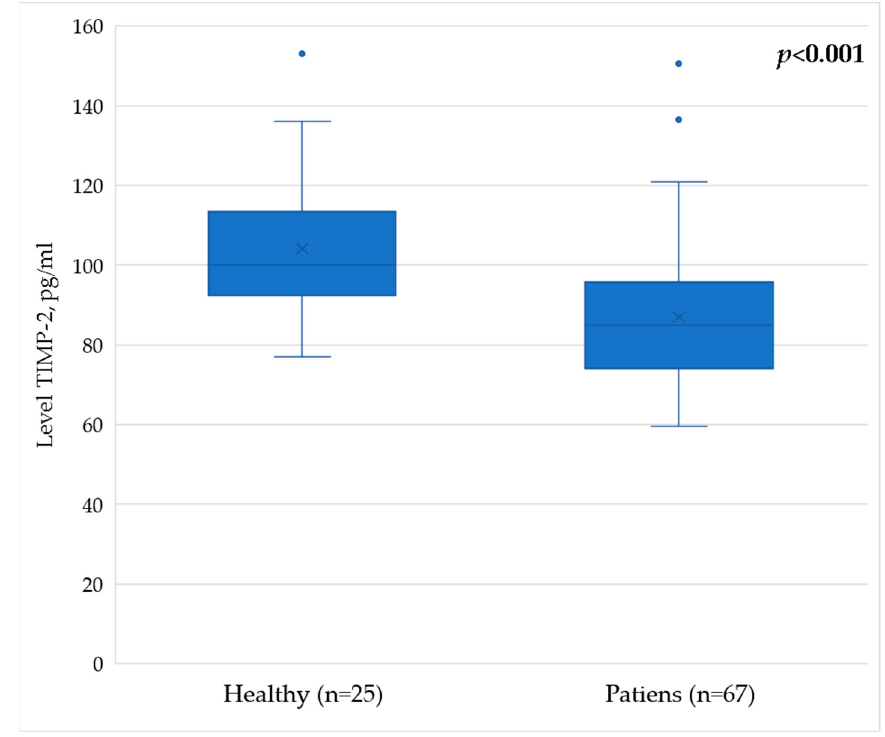
Figure 4. Serum level of TIMP-2 in patients after breast cancer treatment and in healthy volunteers.